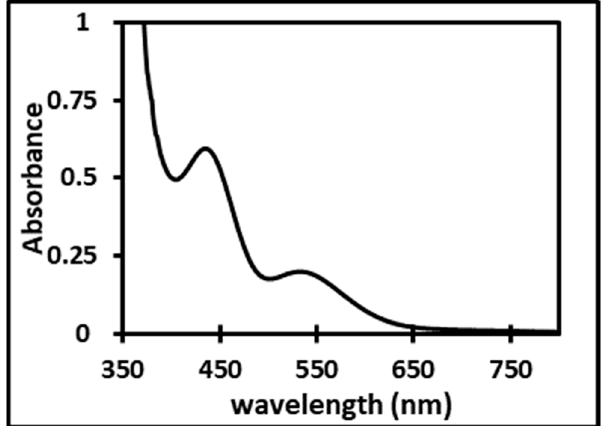
Figure 6. Absorption spectrum of the Rh species extracted in the IL phase.